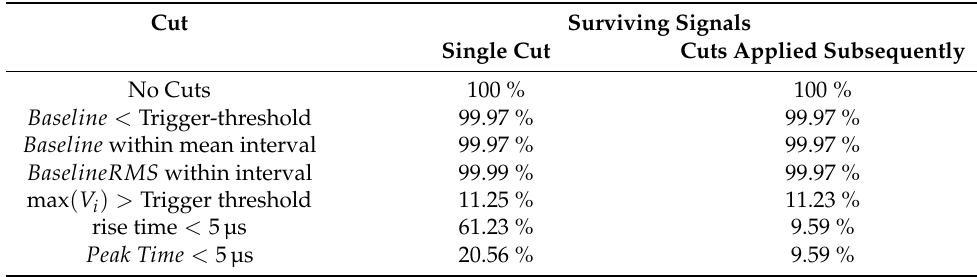
Table 2. The fraction of analyzed waveforms rejected for each data cleaning cut for a run where no sparking was observed.